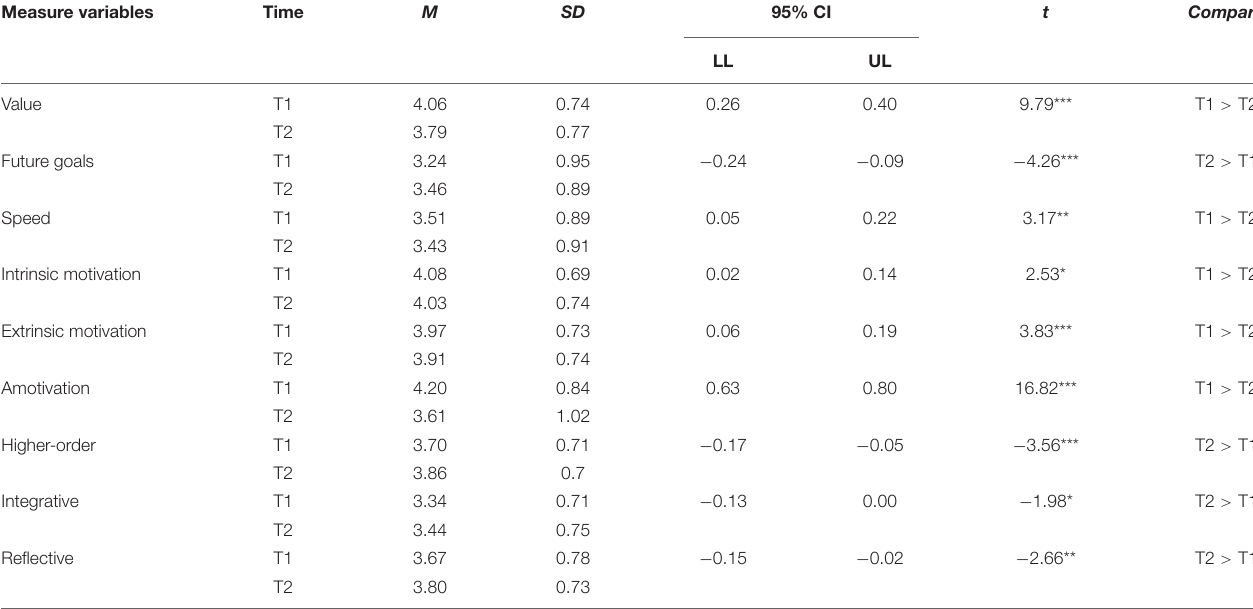
TABLE 3 | Paired-sample t -test of measure